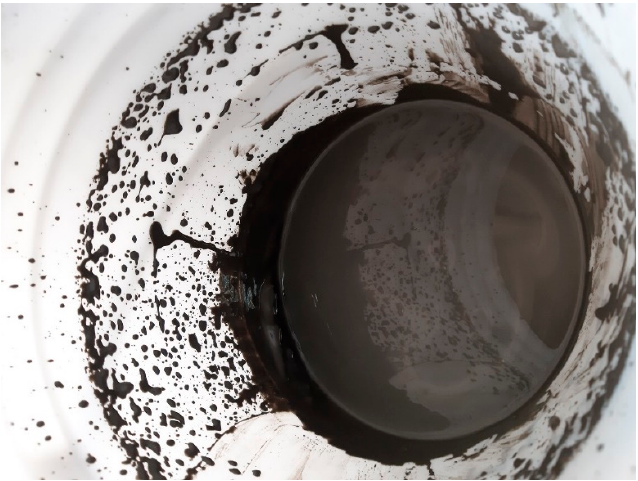
Figure 10. Consistency of Method III, 1 day set at room temperature.